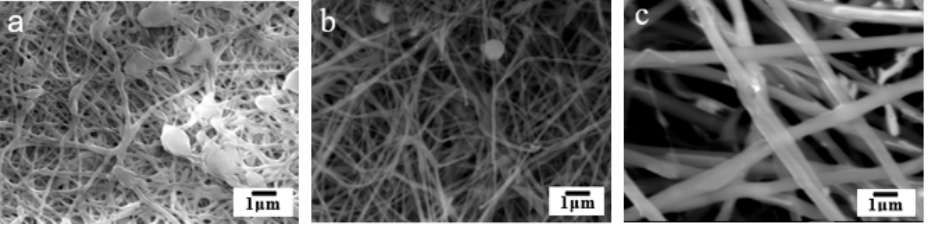
Figure 2. The SEM micrographs of SF/GEL ( a ), SF/GEL/KA-N ( b ), and SF/GEL/KA-N/AgNWs ( c ) porous fiber films.